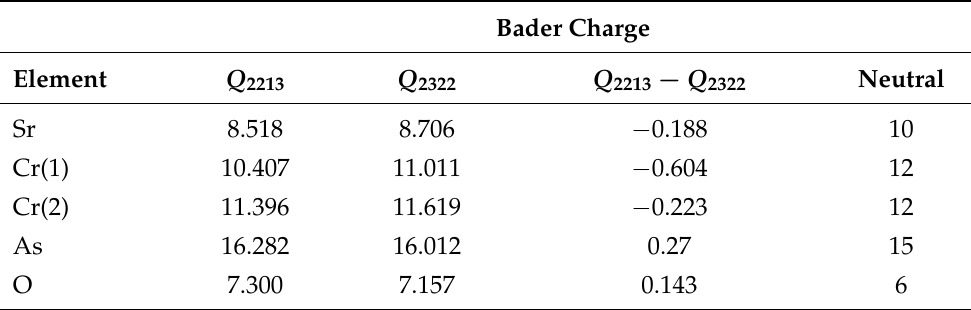
Table 4. Bader charges of different elements in the magnetic ground states of Sr 2 Cr 2 AsO 3 (2213) and Sr 2 Cr 3 As 3 O 2